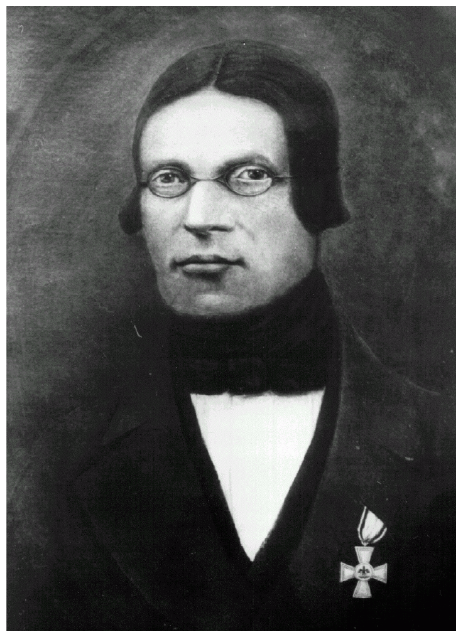
FIGURE 1. Undated photograph of the agronomist and chemist Carl Sprengel (1787–1859), one of the founders of agricultural chemistry, who recommended the use of mineral N fertilizers as early as